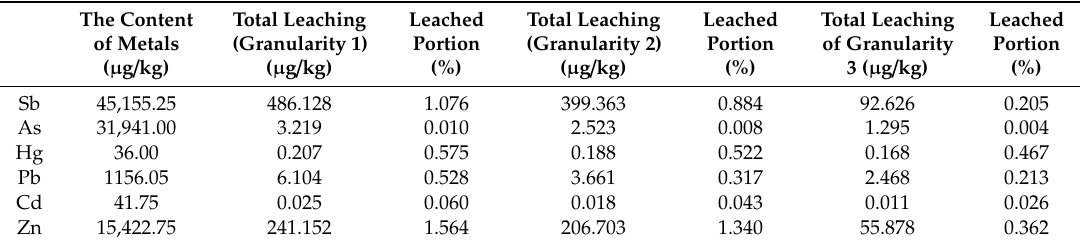
Table 2. Total leaching amount and leaching rate of heavy metals from antimony ore waste rock with different particle sizes.